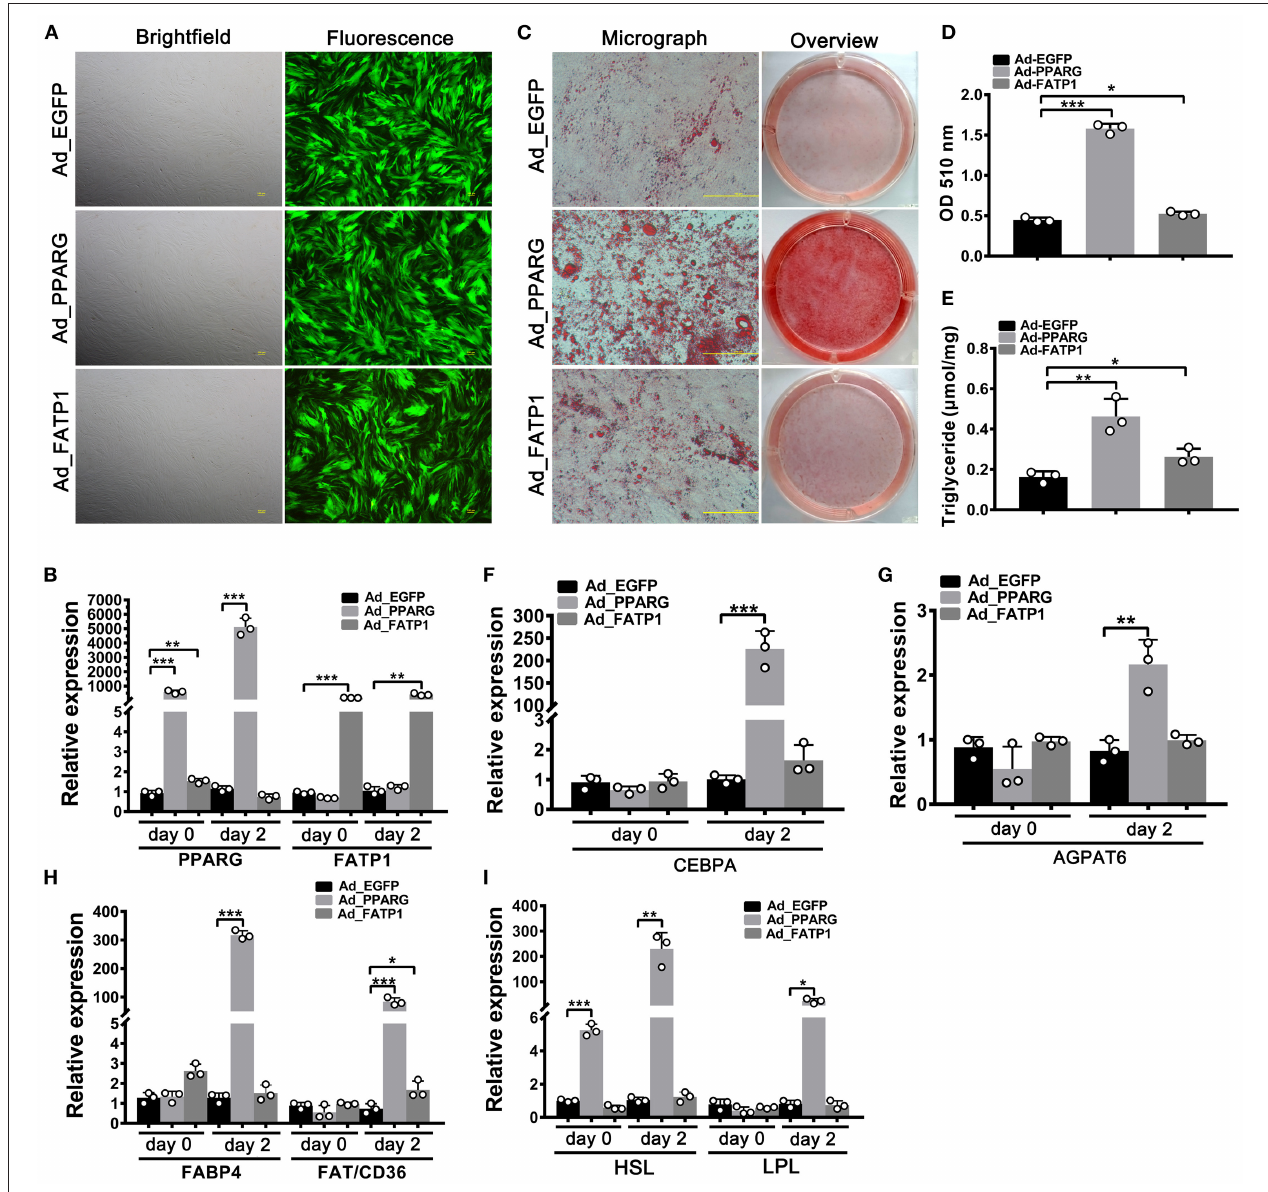
FIGURE 2 | The overexpression of FATP1 promotes lipid accumulation in buffalo myocytes. (A) Micrographs of buffalo myocytes 2 days after adenovirus transduction under bright and fluorescent light. Scale bar, 100 µ m. The mRNA expression levels of PPARG and FATP1 (B) , the adipogenic gene CEBPA (F), the lipogenic gene AGPAT6 (G) , the fatty acid uptake-related genes FABP4 and FAT / CD36 (H) , and the lipogenesis genes HSL and LPL (I) in the control and experimental groups on day 0 and day 2 of adipogenic trans-differentiation (2 and 4 days after adenovirus transduction, respectively). (C) Oil red O staining of “myocytes” on day 8 of adipogenic trans-differentiation. Scale bar, 100 µ m. (D,E) Quantification of lipid accumulation and triglyceride content in “myocytes” on day 8 of adipogenic trans-differentiation. EGFP overexpression (Ad_EGFP) served as a negative control; PPARG + EGFP overexpression (Ad_PPARG) served as a positive control; FATP1 + EGFP overexpression (Ad_FATP1) served as the experimental group. Data are presented as means ± SD, * p < 0.05, ** p < 0.01, *** p < 0.001.